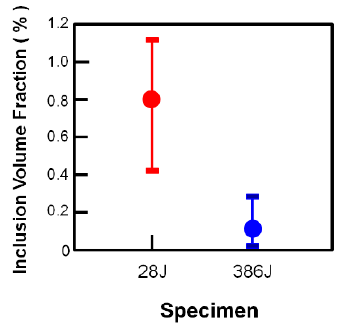
Figure 6. The experimentally measured specimens and the amount of inclusions.